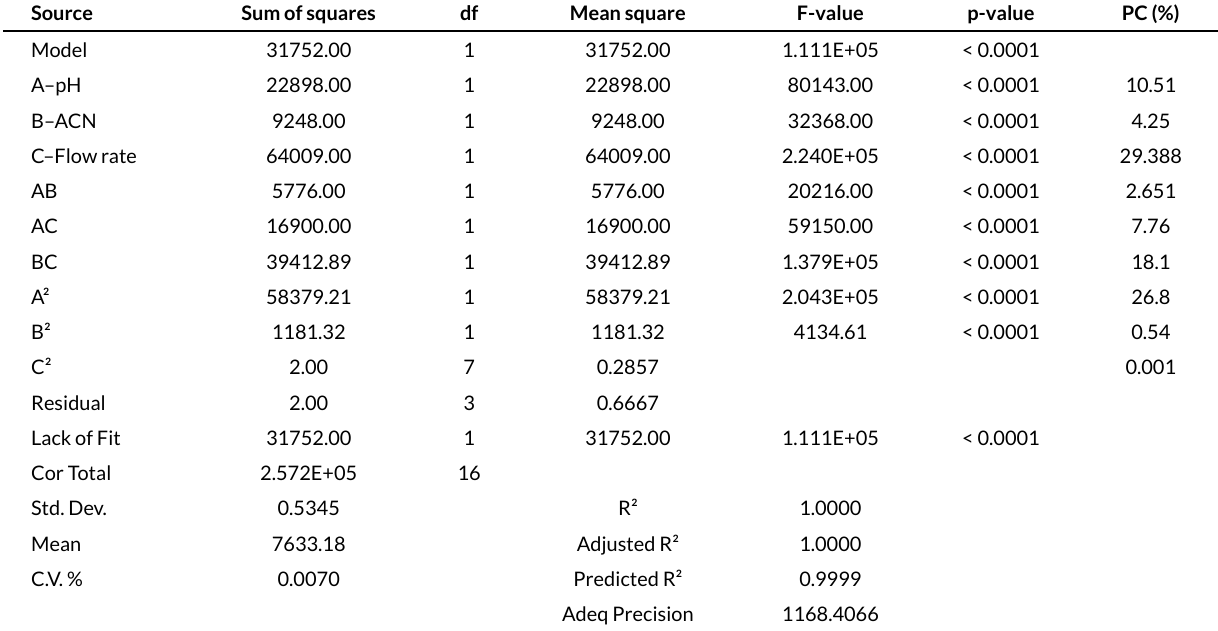
Table 6. ANOVA with theoretical plate response in the contribution of parameters in the Quadratic model to quantify acetic acid